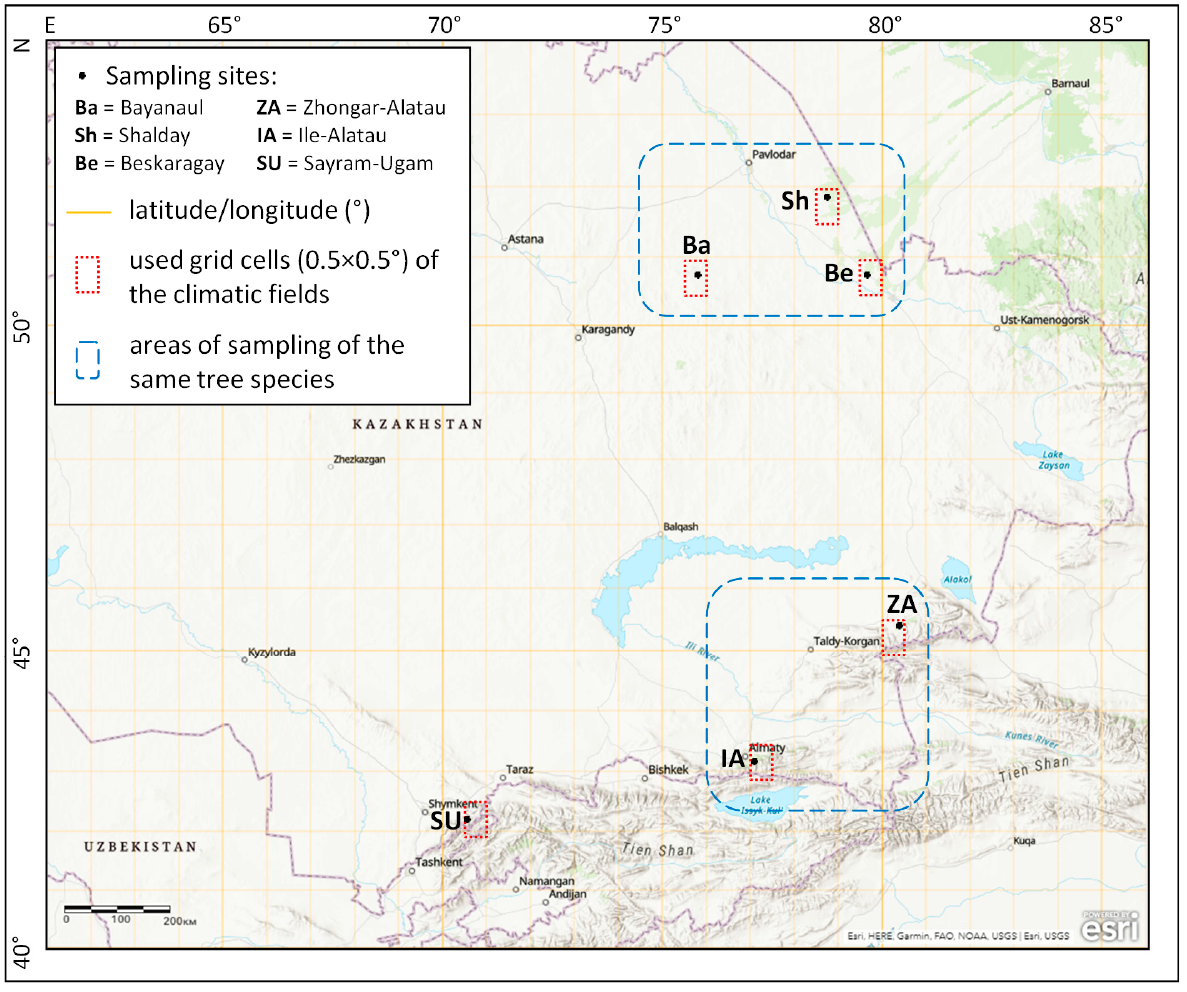
Figure 1. The study area. Markers represent sampling sites (Ba—Bayanaul, Sh—Shalday. Be— Beskaragay, ZA—Zhongar-Alatau, IA—Ile-Alatau, SU—Sairam-Ugam); small dotted rectangles represent geographic grid cells 0.5 × 0.5° for which climatic series from spatially distributed fields were used in correlation analysis; dashed rectangles mark sites where the same tree species were sampled. The map was created in the ArcGIS tool (https://www.arcgis.com/home/webmap/viewer. html; accessed on 10 April 2023) © Esri. Table 1. Location of the sampling sites.